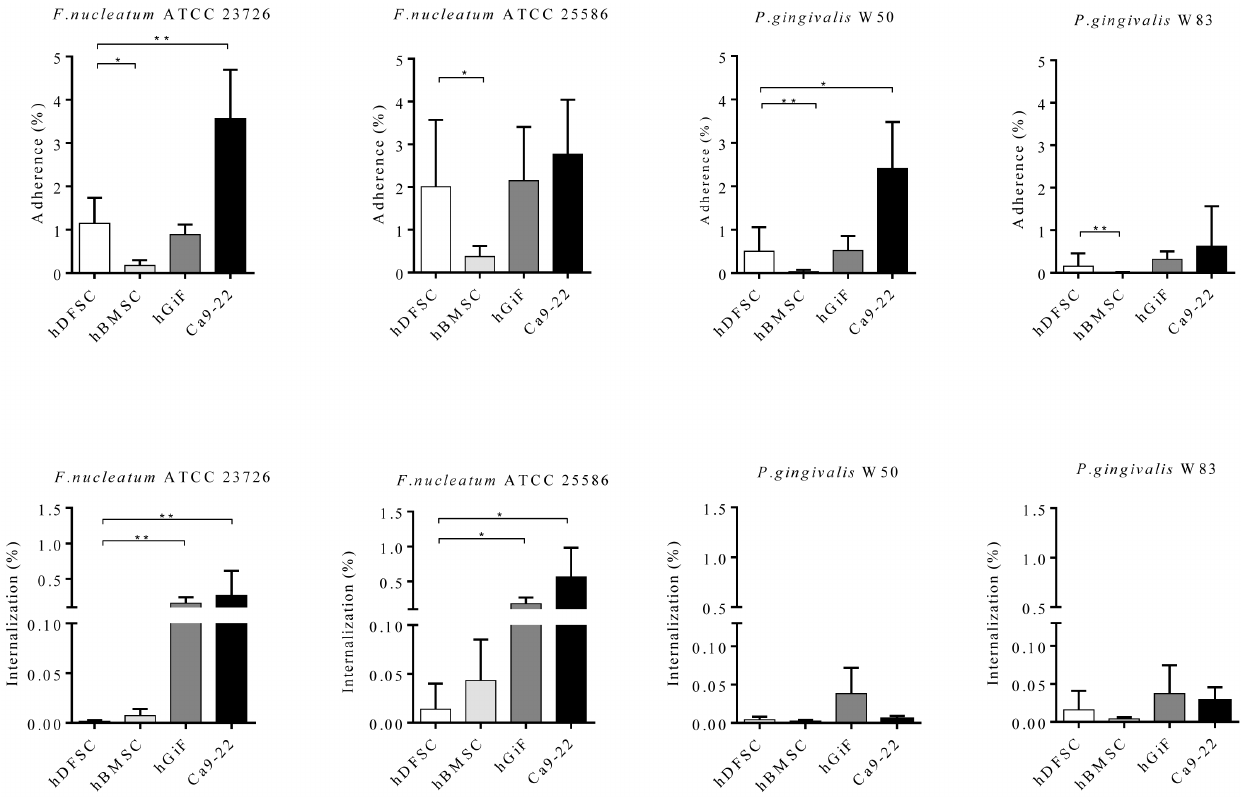
Figure 3. Adherence and internalization. The attachment levels are expressed as the percentage of live bacteria retrieved following cell lysis relative to the total number of bacteria at each timepoint. The assays were carried out as described in the text. Attachment levels of hDFSC were compared to hBMSC, hGiF, and Ca9-22. Values represent the means 6 SD, *p , 0.05, **p=0.01 (T-test), n=4.